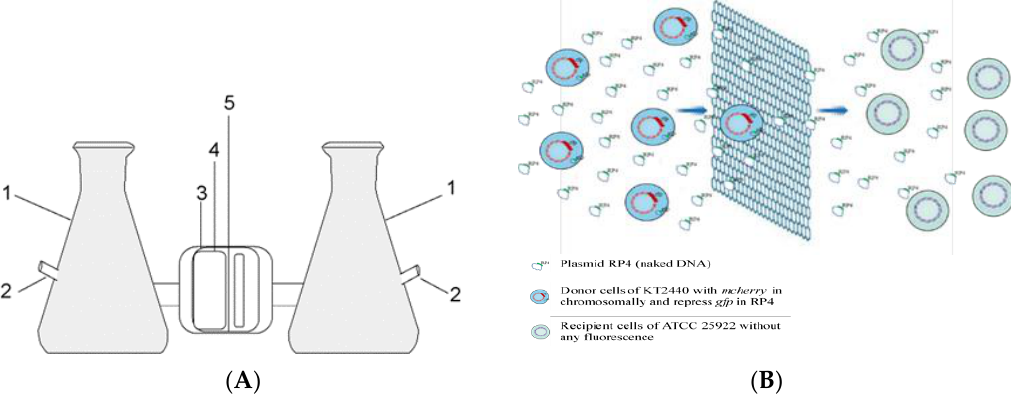
Figure 2. Schematic illustration of U-tube: ( A ) structure of U-tube, icon 1 is culture flask; icon 2 is suction filter joint; icon 3 is flange; icon 4 is silicone gasket; icon 5 is 0.22 μm filter membrane; ( B ) principle of U-tube, showing that plasmid RP4 can be exchange from left to right, but donor cells cannot.